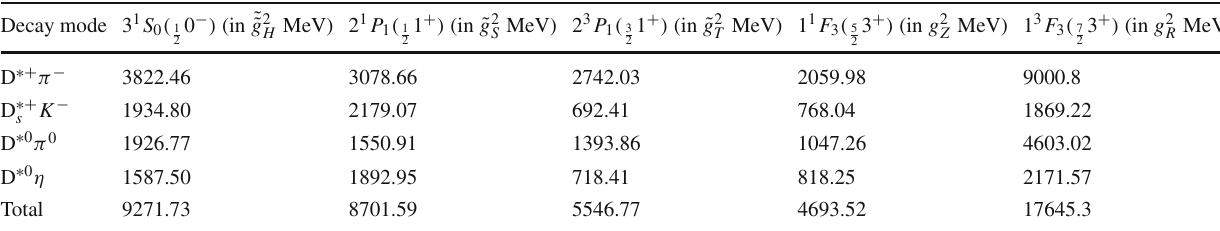
Table 11 The strong decay widths (in MeV) for resonance D J ( 3000 ) with possible spin-parity